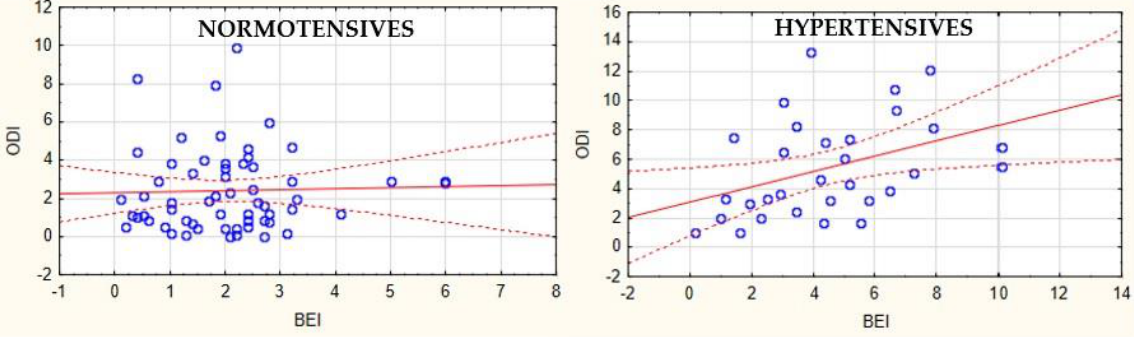
Figure 2. Correlation between ODI and BEI among hypertensives (r = 0.37, p < 0.05) and normoten- sives (r = 0.03, p > 0.05). ODI, oxygen desaturation index; BEI, bruxism episode index.